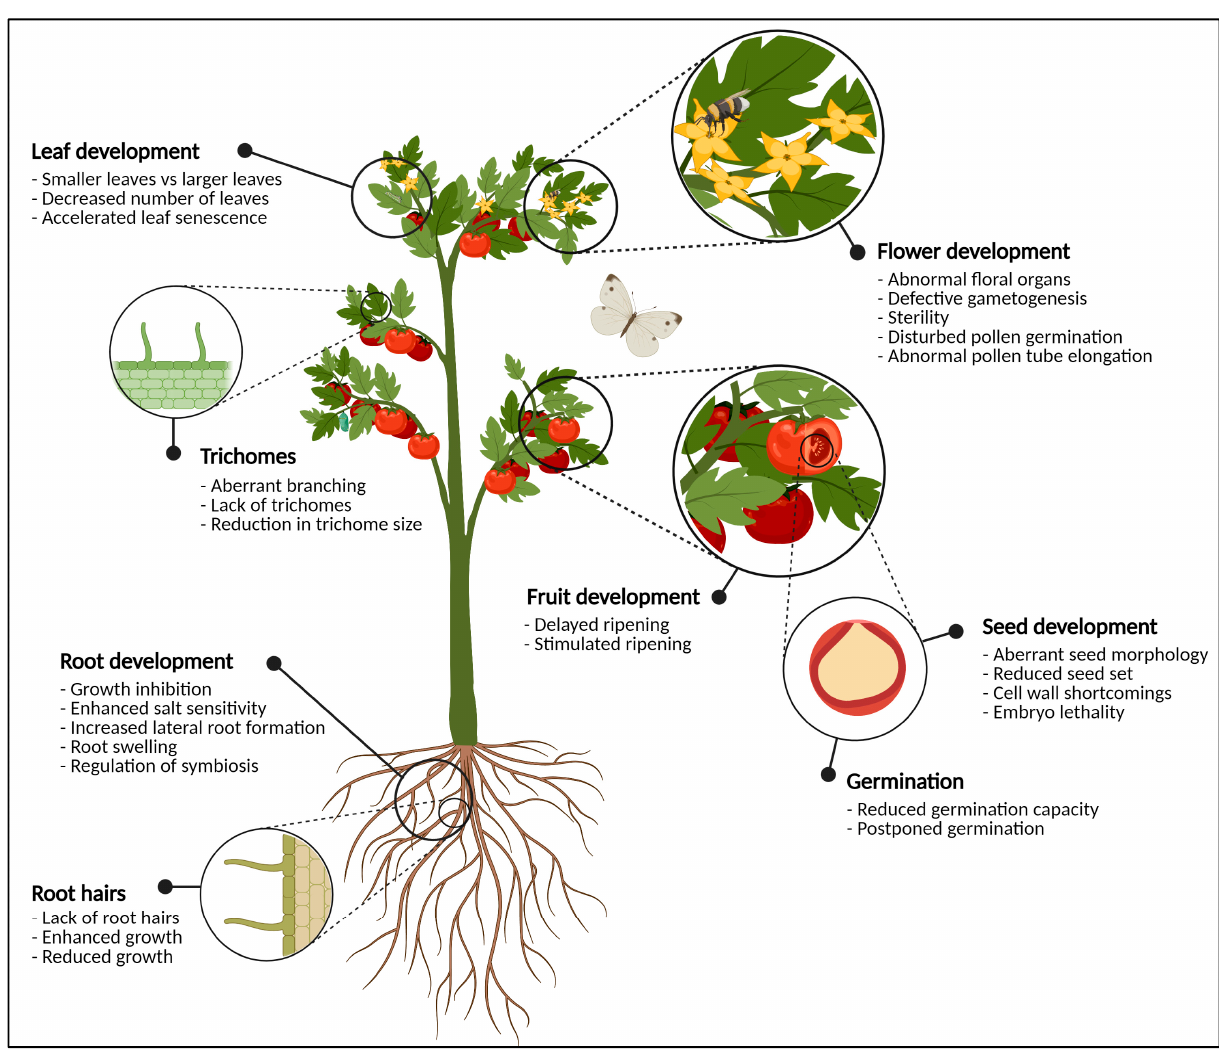
Figure 1. Graphical representation of the most important plant organs. The plant in this figure is generic and does not necessarily represent tomato. For each organ, the most significant phenotypical traits when glycosylation enzymes are knocked-out, knocked-down or over-expressed are highlighted. In the flowering parts, defects in glycosylation cause abnormal development of anthers and pistils, pollen tube germination and elongation, and defective gametogenesis which often leads to sterility. At the level of the fruit, glycosylation enzymes are important for fruit ripening and softening. Seeds show aberrant seed morphology, seed set, (embryo) lethality and cell wall defects when the expression of one or more glycosylation enzymes is disturbed. Vegetative tissues such as the leaves and the roots also experience morphological changes due to aberrant protein glycosylation. This figure was created with BioRender.com.